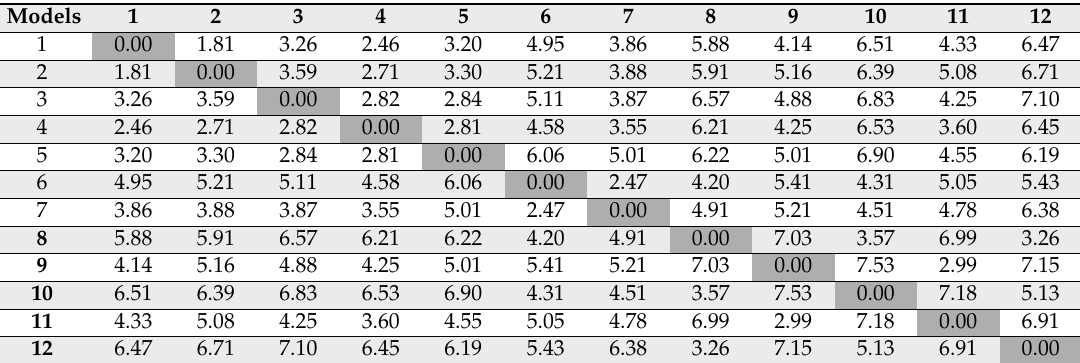
Table 2. CABS-flex server results of tau with 12 simulated models along with the C α RMSD scores between predicted models. The least RMSD model was considered to be the best refined model for further